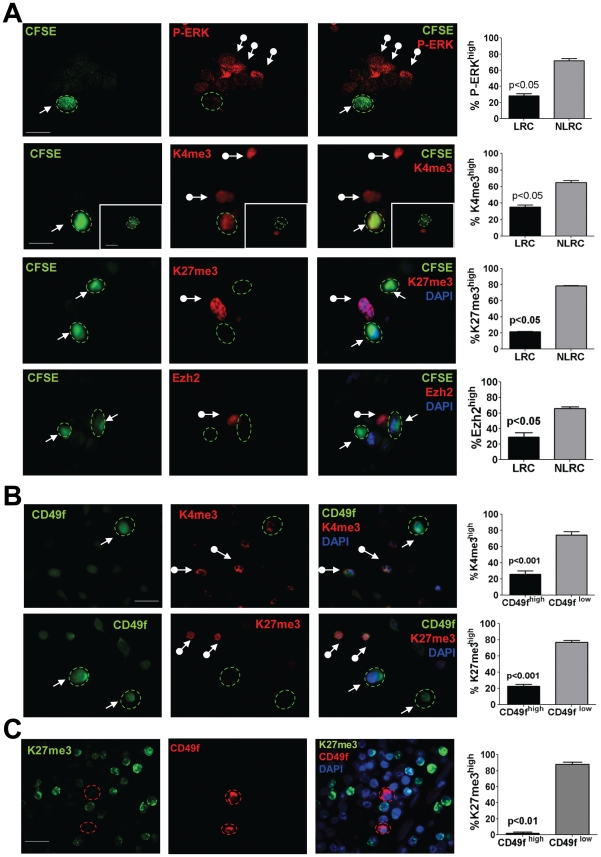
Characterization of ERK signaling and H3 post-translational modifications in TICs.(A) Detection of K27me3, K4me3, EZH2 and P-ERK1/2 by IF in CFSE-labeled HEp3 cells grown in vivo for 4 days. Representative images, LRCs stained for P-ERK (confocal scanning image – scale bar = 60 µm), K27me3, K4me3 and EZH2 (all standard fluorescence microscopy images – scale bar = 80 µm- scale bar inset = 60 µm). Contour of LRCs is delineated with a dashed green line. Arrows = LRCs, arrows with circle = NLRCs. Quantification of marker-positive or negative in LRCS and NLRCs is shown in the graphs on the right. Y axes show the percentage of cells per tumor. Graphs show mean ± SD of three independent tumors. (B) Detection of CD49f, K27me3 and K4me3 in HEp3 cells grown in vivo 6 days. Representative images of CD49f, K27me3 and K4me3, standard fluorescence microscopy images – scale bar = 80 µm- Contour of CD49fhigh cells is delineated with a dashed green line. Arrows = CD49fhigh, arrows with circle = CD49flow. Quantification of marker-positive or negative in CD49fhigh and CD49flow cells is shown on the graphs on the right. Y axes show the percentage of cells per tumor. Graphs show mean ± SD of three independent tumors. (C) Detection of K27me3 and CD49f in sections from human oral primary tumors (PT68880). Scale bar = 80 µm. CD49f positive cells are delineated with a dashed red line. Y axes show the percentage of cells per section. p-values estimated using Mann-Whitney non-parametric test.